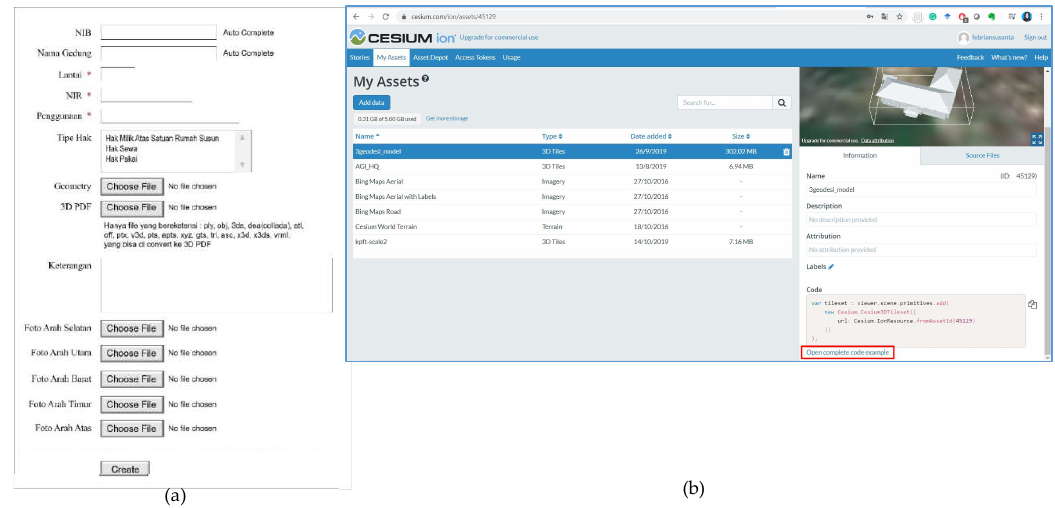
Figure 8. ( a ) An interface to add / upload 3D spatial building data in form of KML; ( b ) an interface to upload a building 3D model with the CityGML format via Cesium ion.